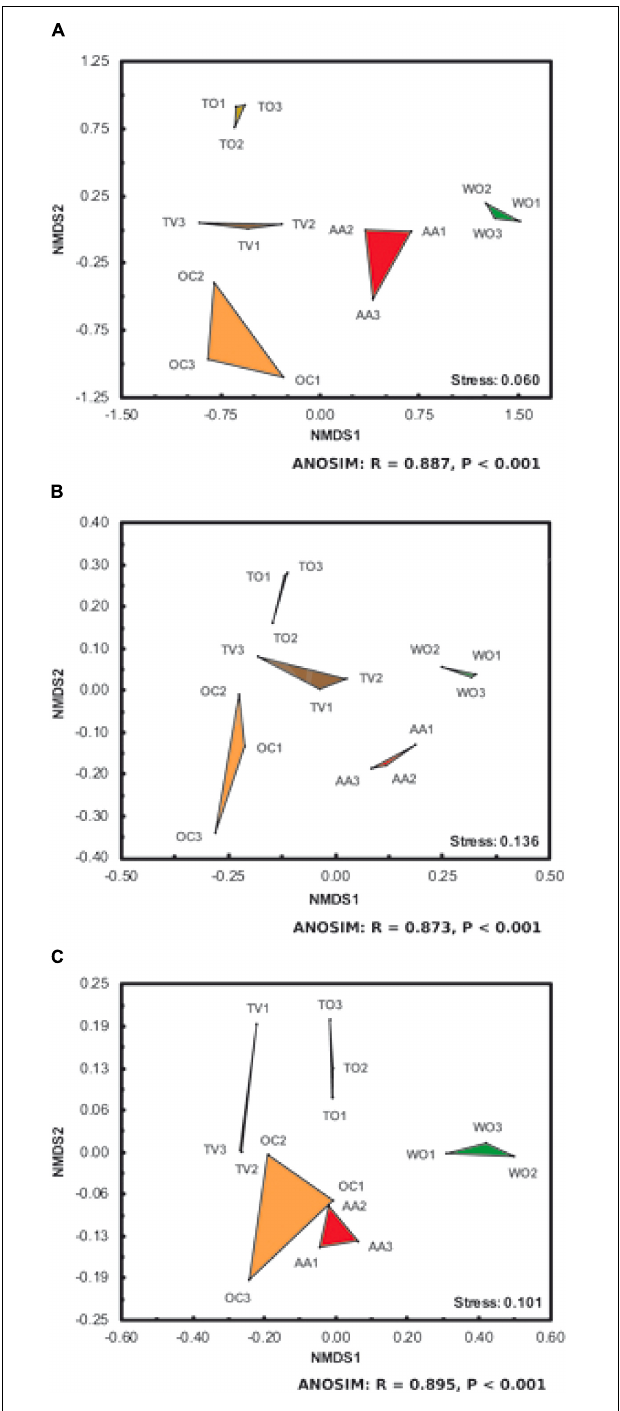
FIGURE 3 | Non-metric multidimensional scaling (NMDS) of (A) phylogenetic dissimilarities and (B) genus-level structural differences of arbuscular mycorrhizal fungal (AMF) communities ( β -diversity), and (C) differences in soil microbiological and chemical properties under five land-use types. See Figure 1 for land-use abbreviations. Each land-use type is represented by three fields on different farms ( Supplementary Figure S1 ). The corresponding stress values and results of analyses of similarity (ANOSIM) are listed at the bottom right of each subfigure.